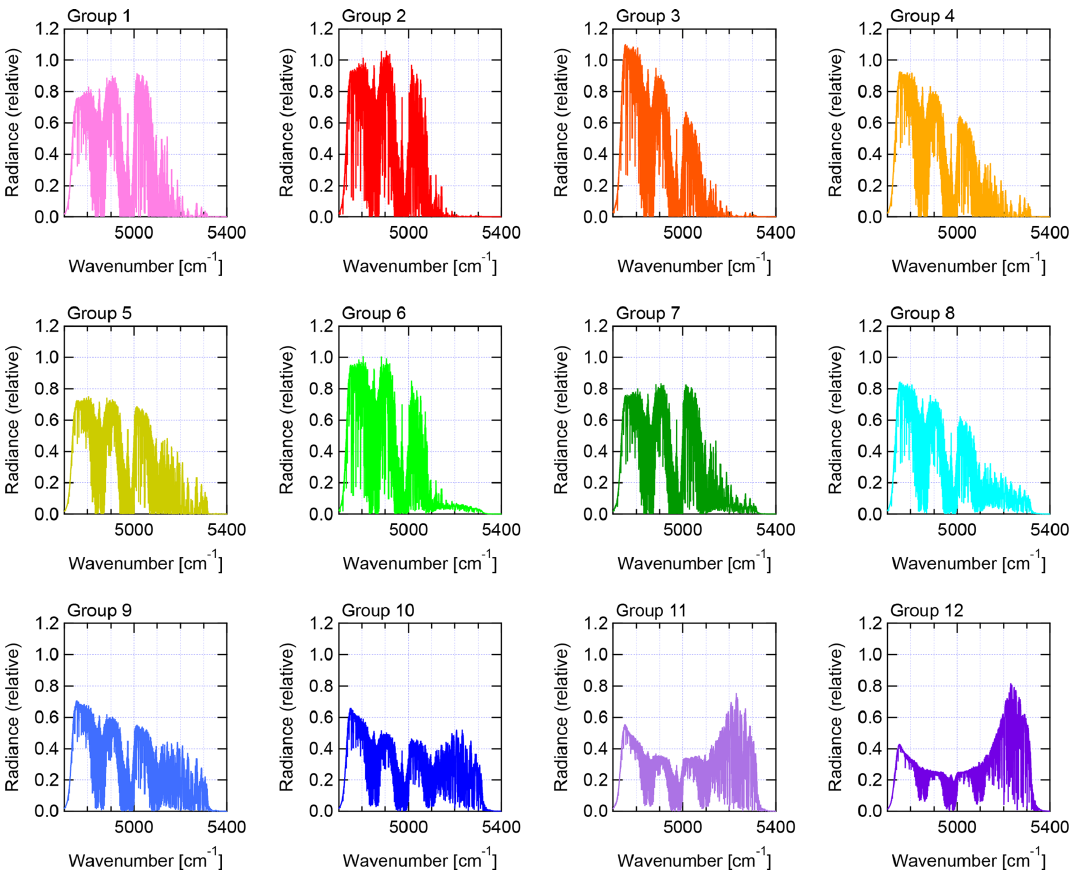
Figure 3. The 12 spectral groups of Band 3P spectra derived using k means clustering. The groups from 1 to 12 were ordered from top left to bottom right.